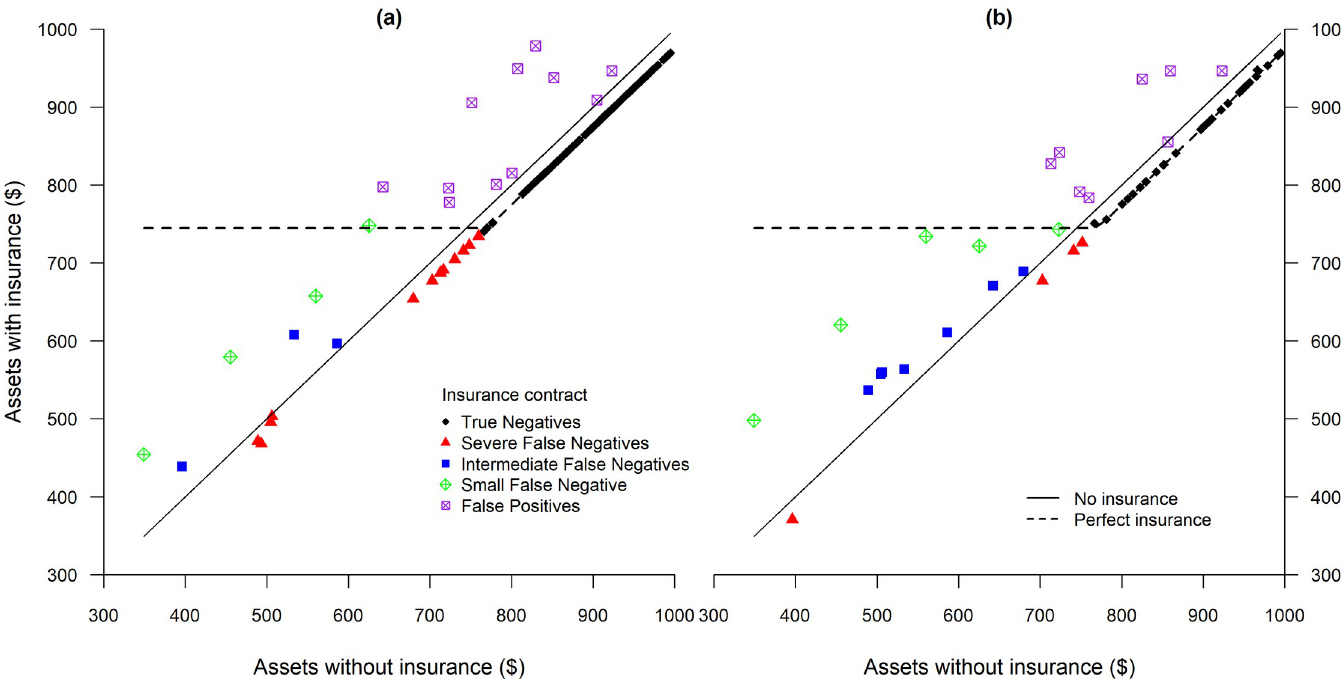
Fig 7. Comparison of perfect insurance contract versus two index insurance contracts with similar R 2 of 0.41 and RIB of 0.41 in (a) and 0.50 in (b). The index insurance contract in (a) in based on segmented (sm) model and lRN predictor while (b) uses piecewise linear with z -scores less than -0.5 (lm5) model and lMD predictor.